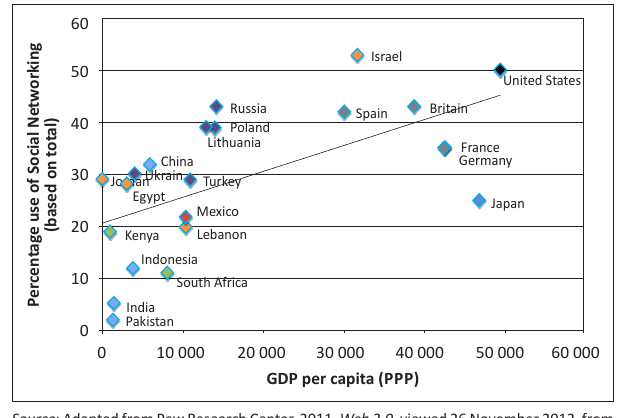
FIGURE 7: The GDP per capita (PPP) and use of social